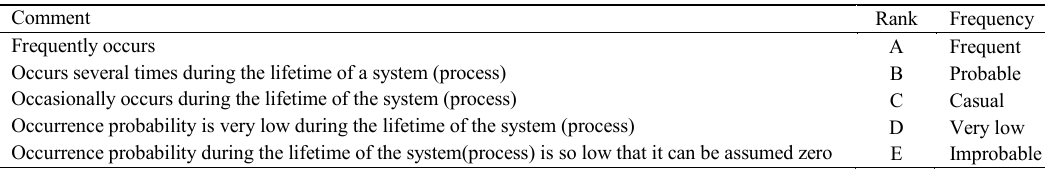
Table 5: Occurrence probability of risks in PHA (Wells et al., 1993; Rooney et al., 1998)